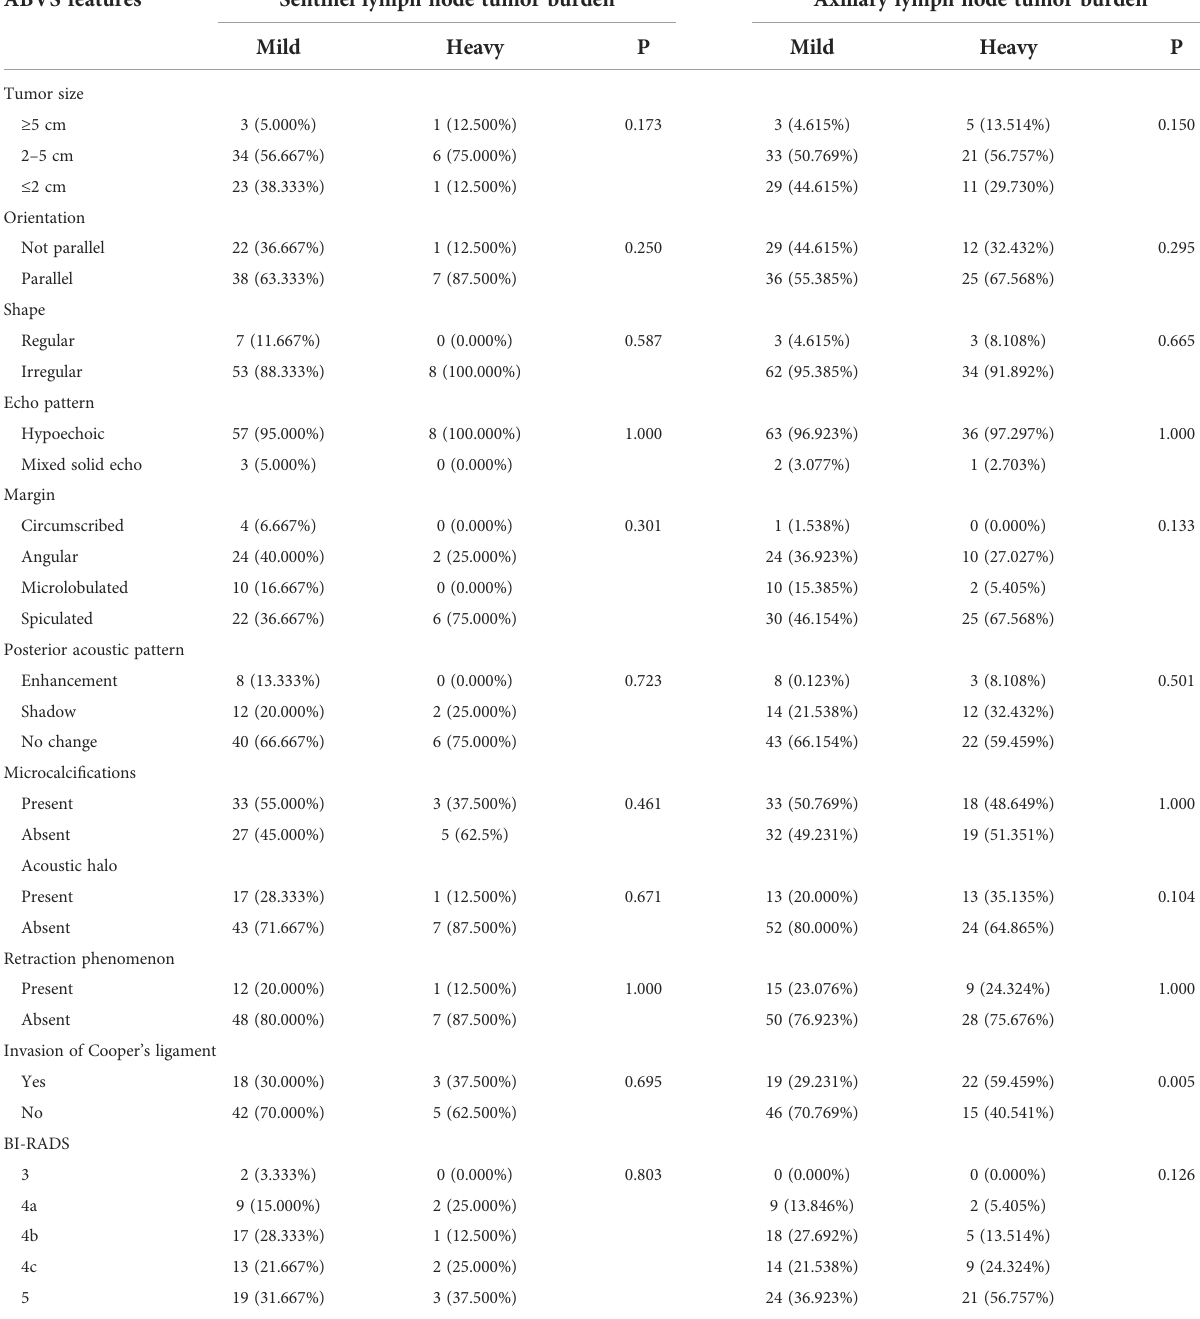
TABLE 3 Differences of lymph node tumor burden of luminal B-type breast cancer regarding different ABVS